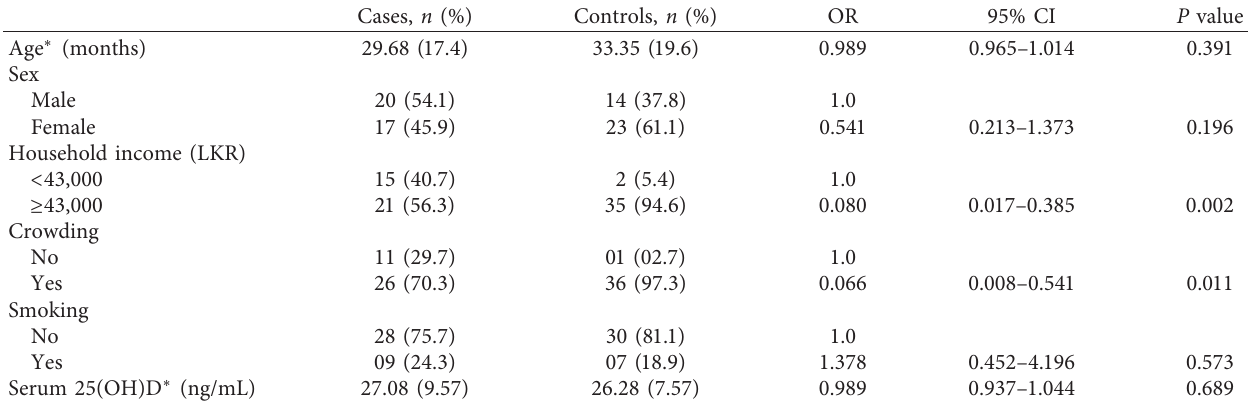
Table 2: Bivariate analysis of factors associated with community-acquired pneumonia.